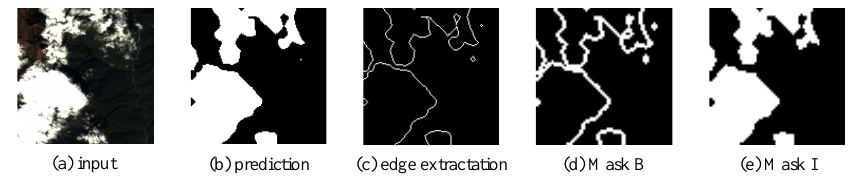
Figure 3. The generation of Masks. ( a ) Input image. ( b ) Prediction result. ( c ) Edge of the prediction result. ( d ) Boundaries area of attention map. ( e ) Inner area of attention